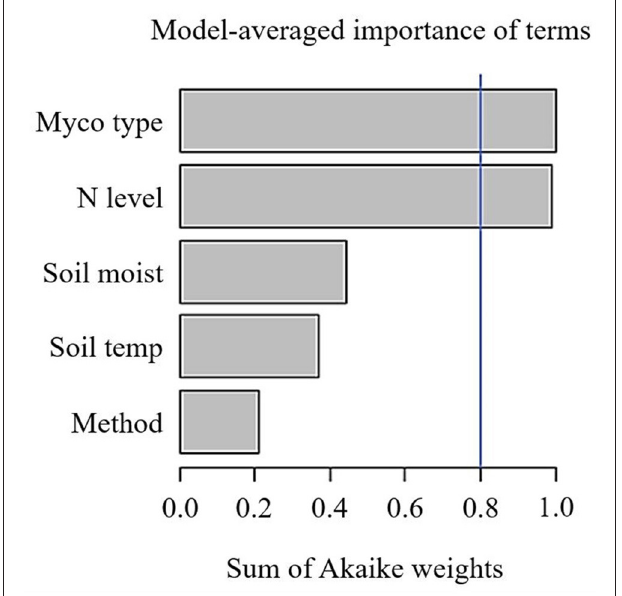
FIGURE 1 | Sum of Akaike weights (AICc) from the multi-model inference for predictors including mycorrhizal type (Myco type), N fertilisation levels (N level), soil temperature (Soil temp), gravimetric soil moisture (Soil moist), Specific root respiration measurement method on N fertilisation effect sizes of specific root respiration. Cut-off value (blue line) is set at 0.8 differentiating between important and less important predictors. N.B. only observations from field experiments are